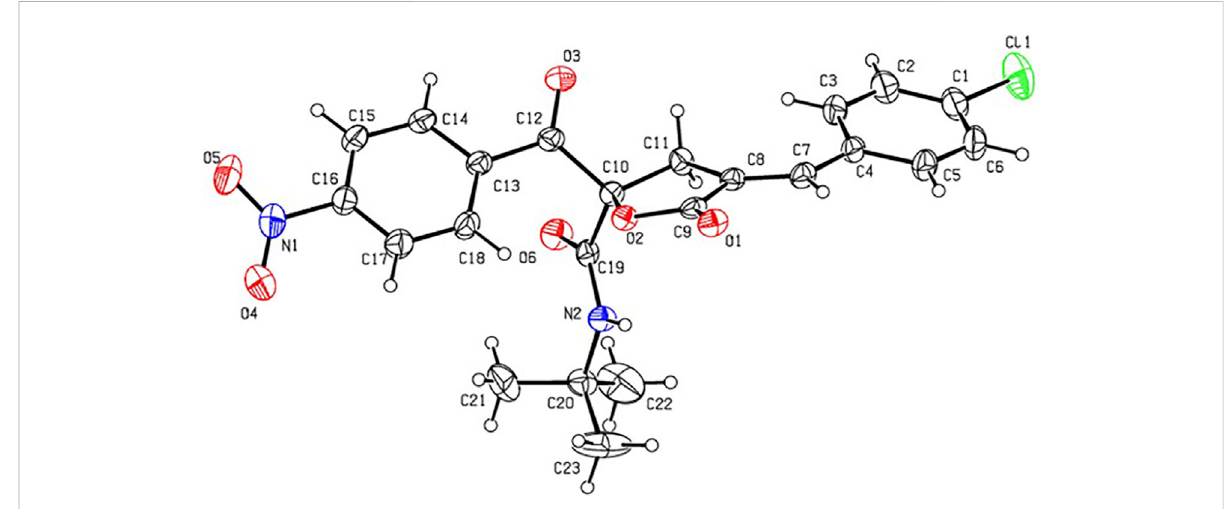
FIGURE 1 Crystal structure diagram of compound RPDFB (CCDC 2179210). Note: black, carbon; white, hydrogen; red, oxygen; purple, nitrogen; green,